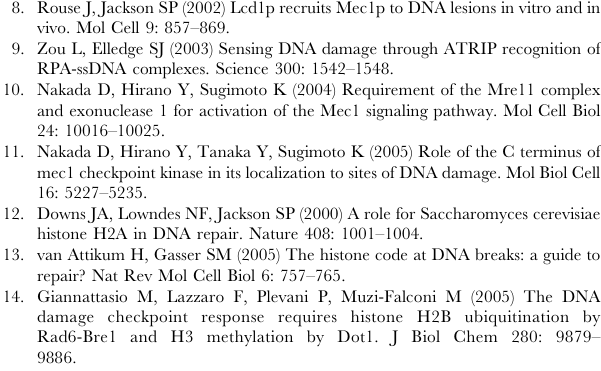
(TIFF) Figure S2 G1-phase DNA damage checkpoint in ddc2-S4 mutants. Wild-type (KSC1178), ddc2 D (KSC1234) and ddc2-S4 (KSC3153) cells were grown at 30 u C, arrested with a -factor, and irradiated or not irradiated with UV light. The percentage of budded cells was scored at the indicated times after release of UV- irradiated ( + UV) and unirradiated ( 2 UV) cultures from a -factor. (TIFF)